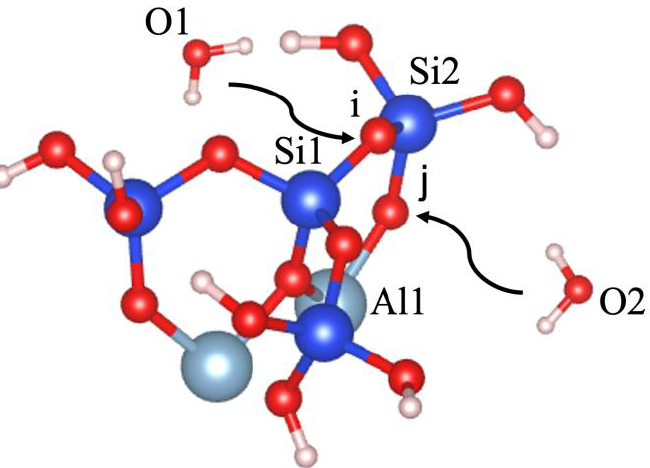
Figure 2. Illustration of the initial scenario for dissolution of silicate tetrahedra (Si(OH) 4 ) depending on the bridging of oxygen to the silicate and aluminate units. Silicate atoms are shown in blue; aluminum in light blue; oxygen in red; and hydrogen protons in white. Results for each scenario